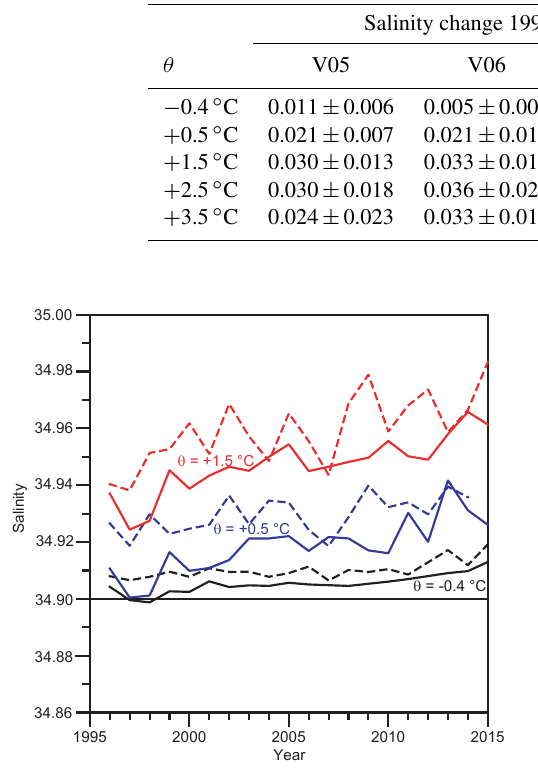
Figure 6. Temporal change of salinity at three fixed potential tem- peratures ( θ) : − 0.4 ◦ C (black), + 0.5 ◦ C (blue), + 1.5 ◦ C (red) for station V05 (continuous) and V06